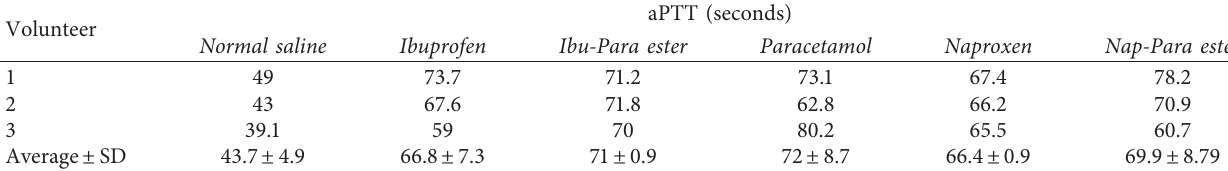
Table 4: The aPTT test